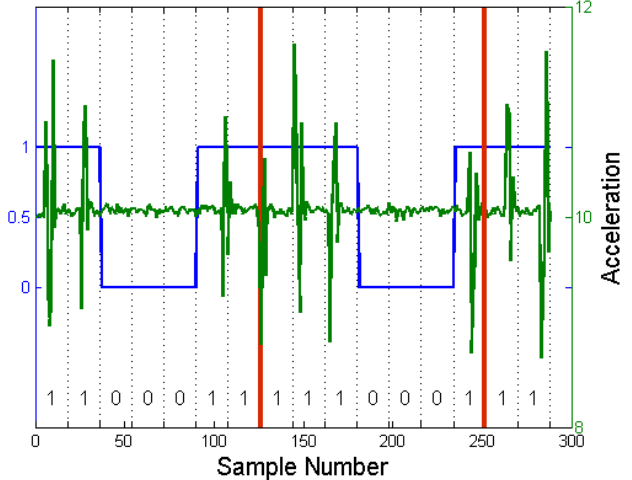
A successive transmission of 1100011 . A bit error occurs due to time synchronization and an inconsistent sampling